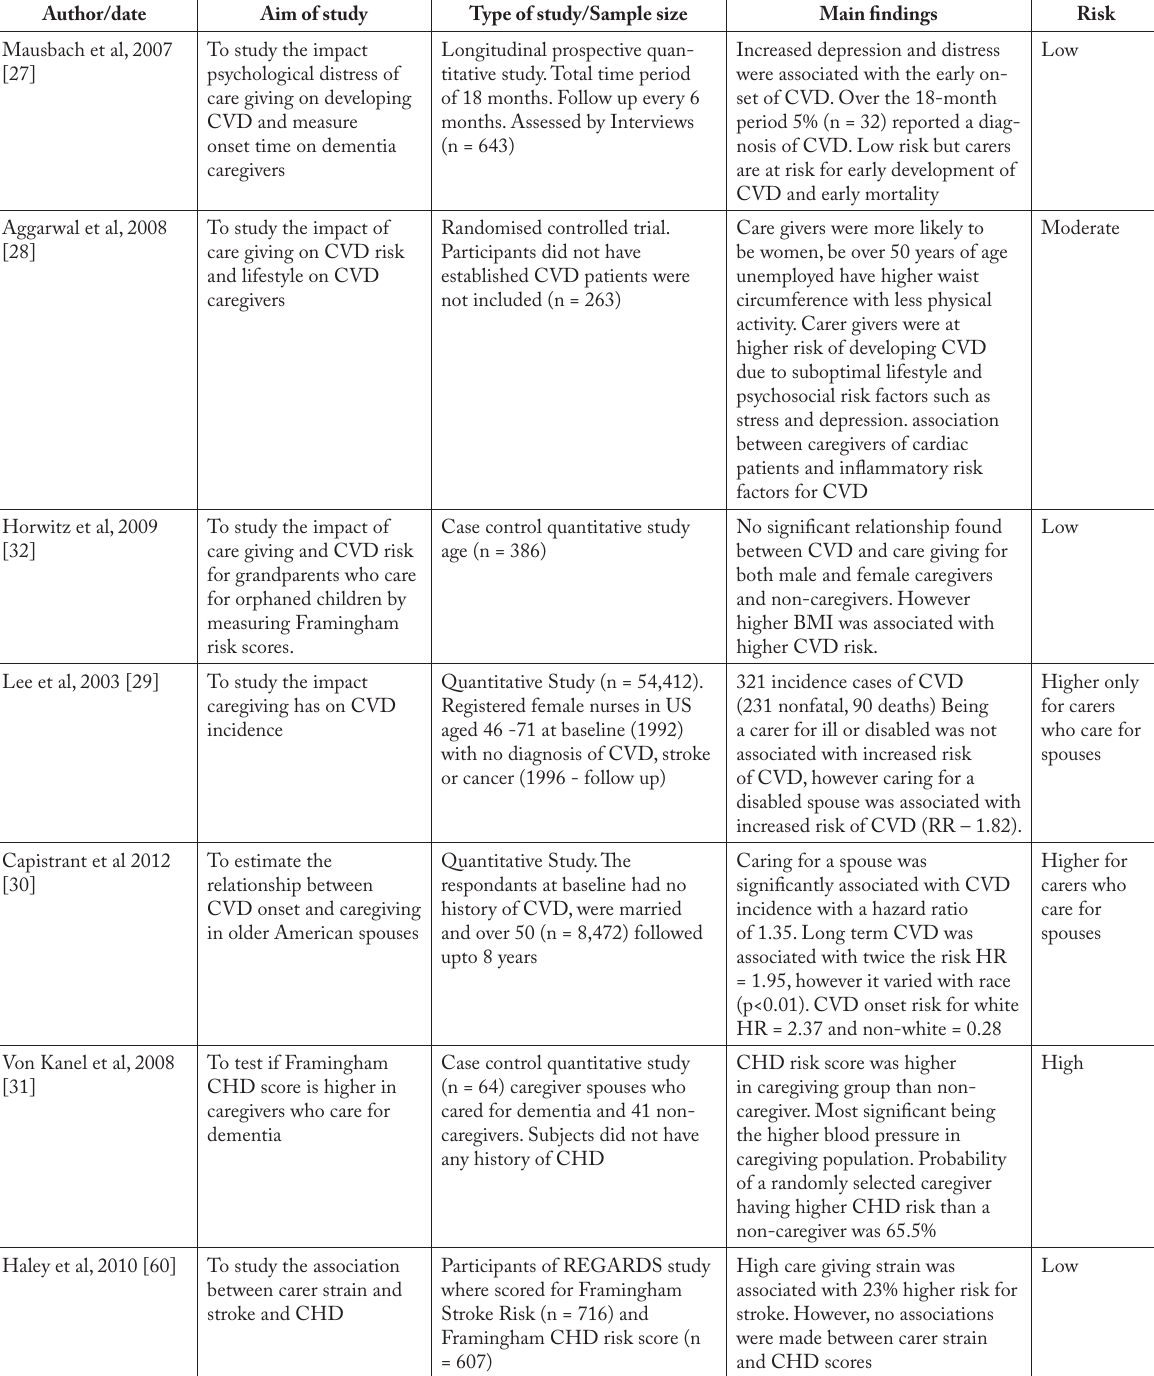
Table 5. Cardiovascular diseases (CVD-CHD) among